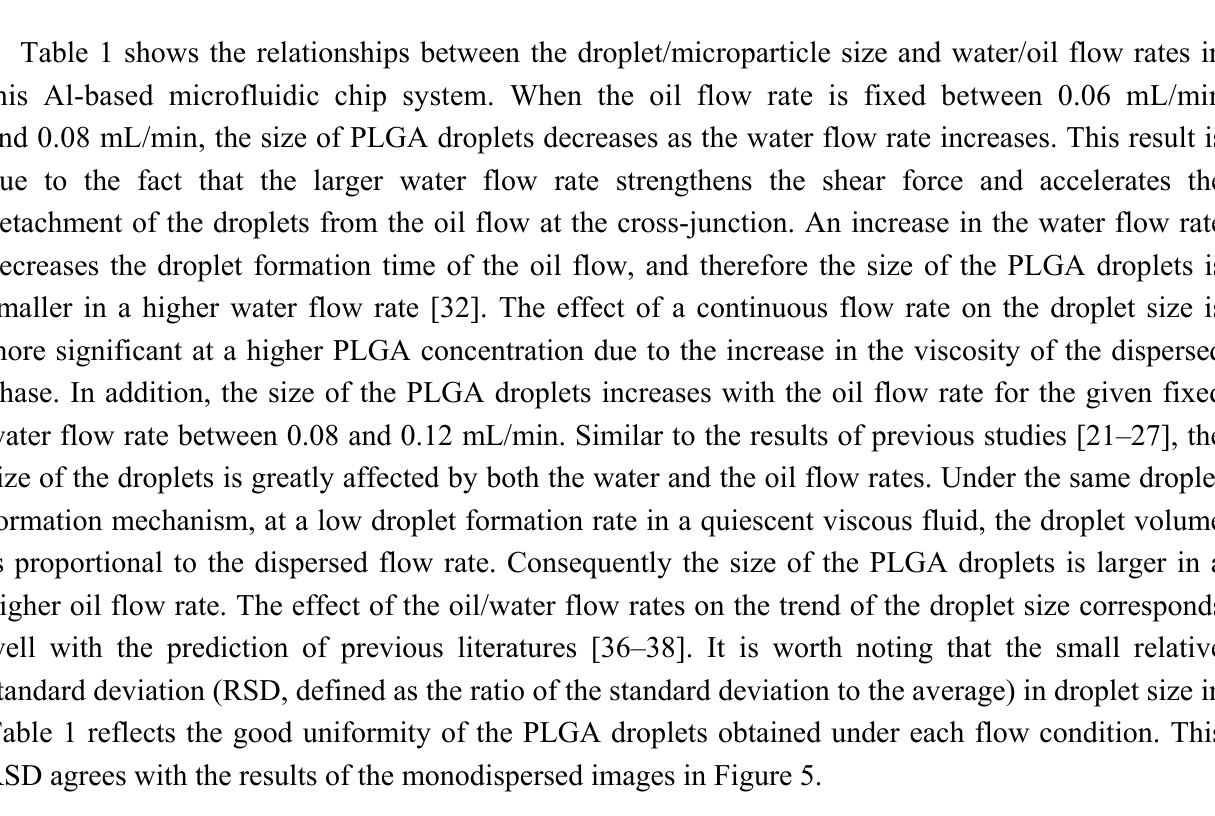
Table 1. The relationships between particle size and flow rates of the two T